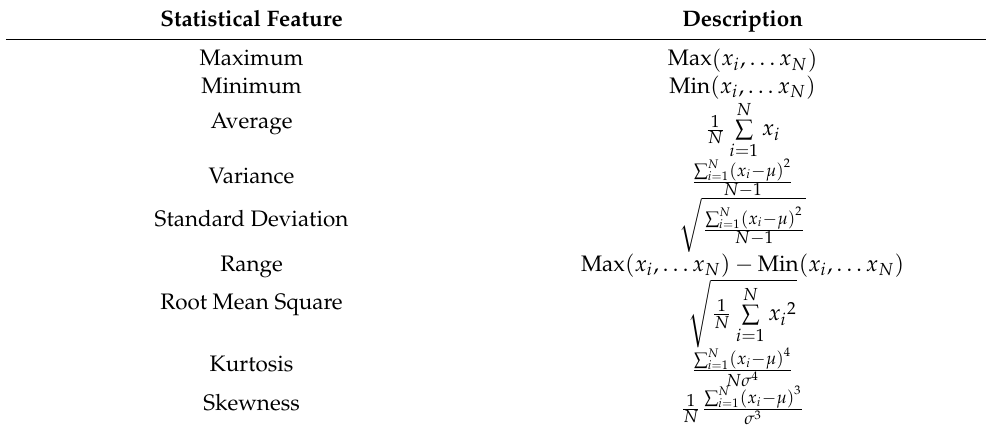
Table 1. Time-domain statistical features extracted from the cleaned dataset.